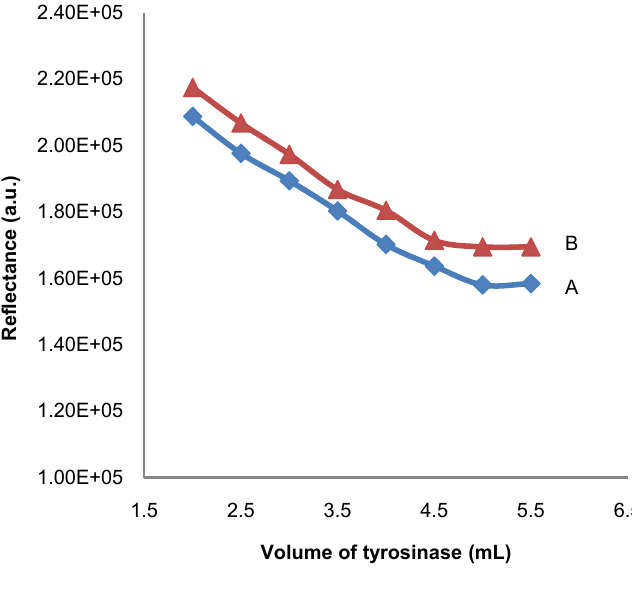
Figure 3. The effect of amount of tyrosinase immobilized into the developed test strip (A) before and (B) after being introduced into100 ppm of benzoic acid